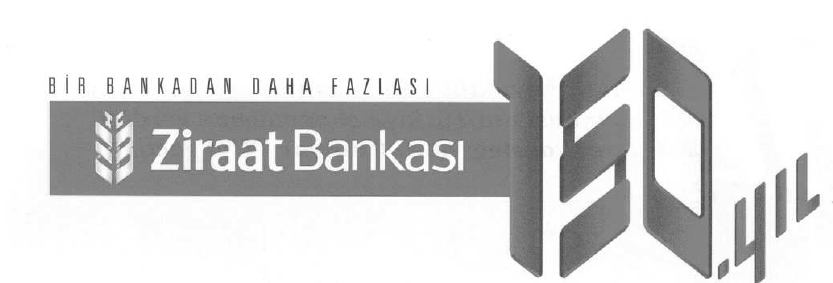
Fig. 7. T.C. Ziraat Bank’s 150th Anniversary Emblem and